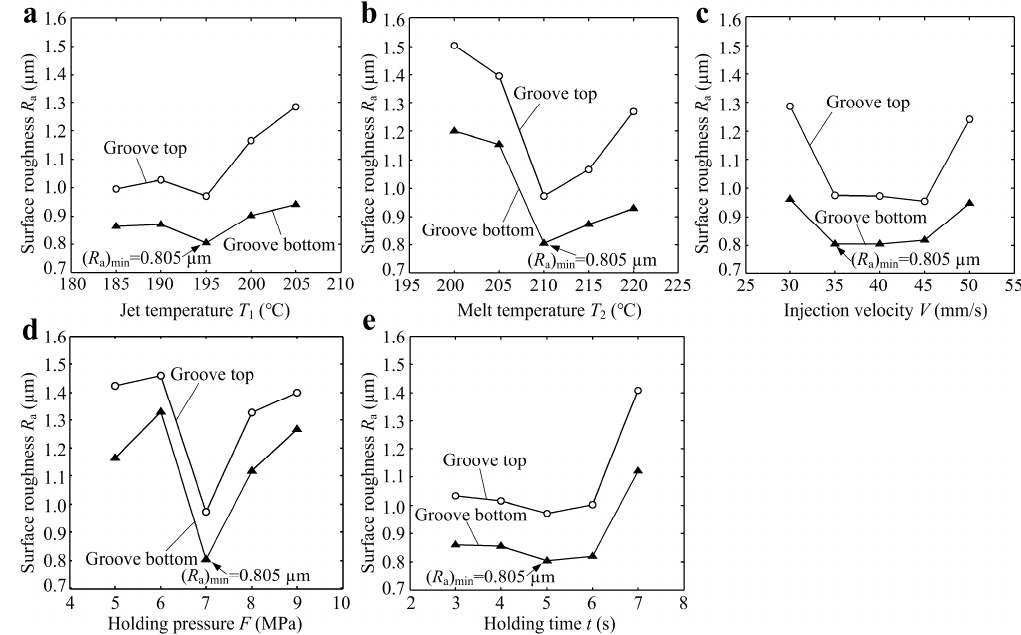
Figure 10. The effects of micro-injection molding parameters on surface roughness R a : (a) jet temperature T 1 ; (b) melt temperature T 2 ; (c) injection velocity V ; (d) holding pressure F ; (e) holding time t .